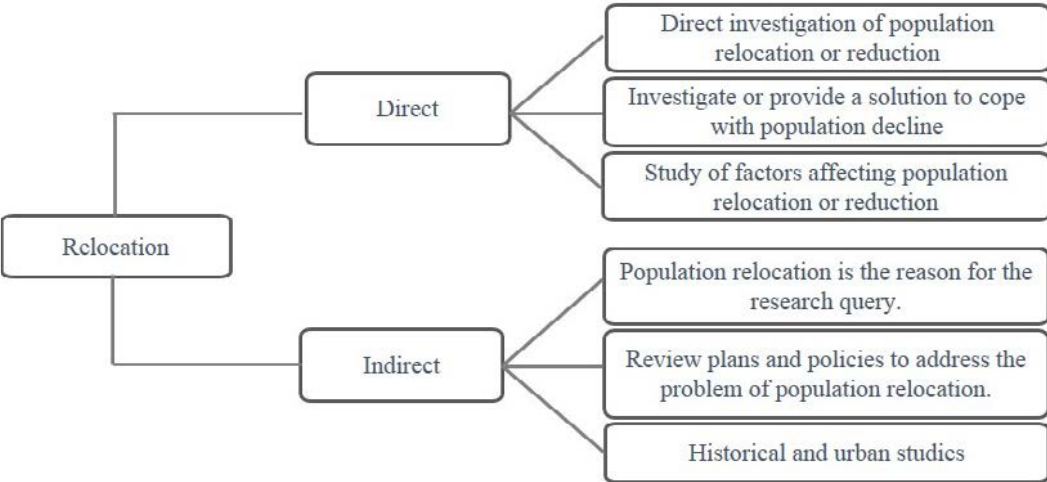
Fig. 5: Categories of addressing community relocation in historic urban contexts